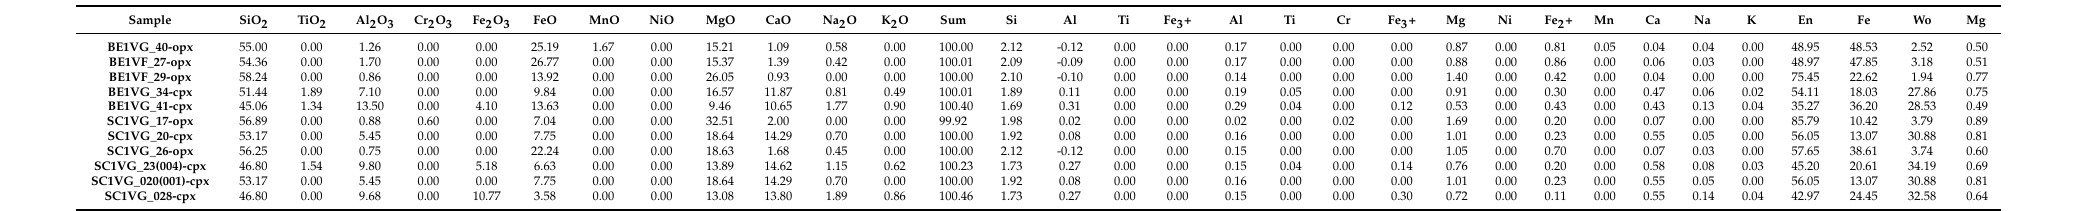
Table A3. Major element compositions of pyroxene